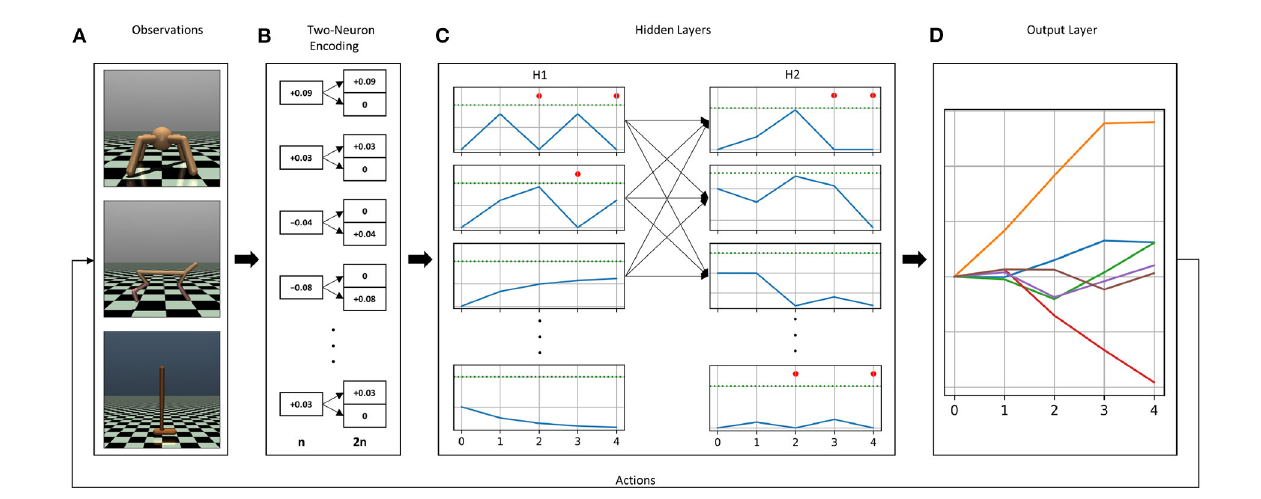
FIGURE1 Overview of the encoding and decoding methods used in our experiments. The continuous control OpenAI Gym environments Ant-v3, HalfCheetah-v3, and Hopper-v3 (A) . Each environment has different observation and action dimensions, which has an impact on the choice of the membrane parameters. Observations are first encoded into a two-neuron input scheme, in which inputs are split into positive and negative neurons for each dimension (B) . The resluting two-neuron encoded input vector is multiplied by the first weight matrix, i.e., the weight matrix connecting the input layer to the first hidden layer, and the resulting values are injected as constant current in the first hidden layer’s neurons. (C) Shows the resulting activity from injecting constant current. Blue curves show the membrane potential, dashed green lines represent the firing thresholds, and the red dots indicate the emission of a spike at that time step. Spikes generated in the first hidden layer will propagate to the second hidden layer, where spiking activity will also be generated. The output layer (D) , contains as many neurons as the number of actions with the firing threshold set to infinity, i.e., neurons without a spiking mechanism. Incoming spikes from the second hidden layer control the evolution of the membrane potentials of the neurons in the output layer. The values of the membrane potentials at the last simulation time step are the chosen actions.